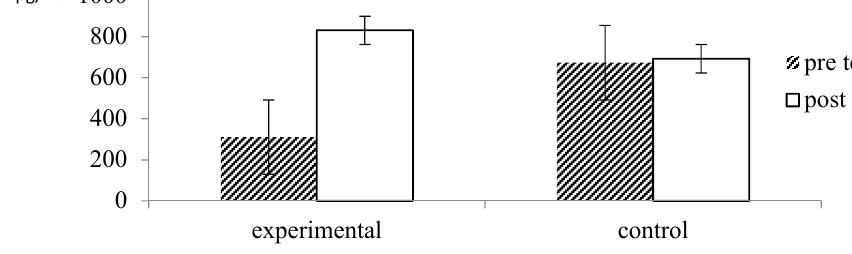
Figure 5. Effect of forest therapy on NK cell activity.